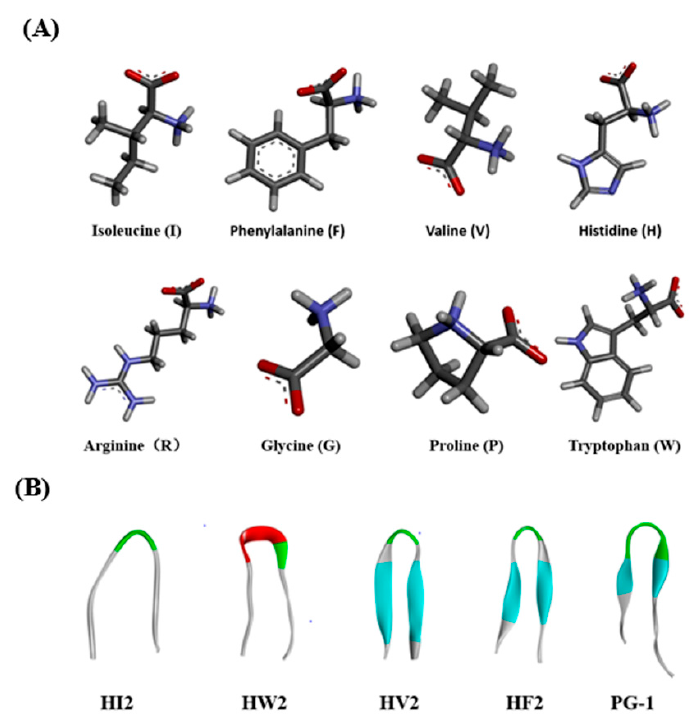
Figure 1. ( A ) Molecular three-dimensional structure of I, F, V, H, R, G, P, and W. ( B ) Peptides three- dimensional structure projections of HI2, HW2, HV2, HF2, and PG-1.